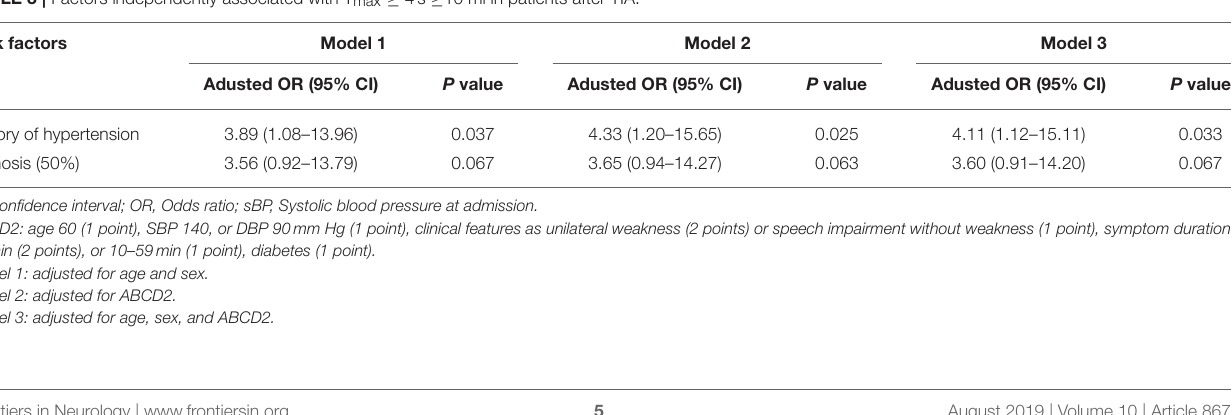
Frontiers in Neurology |